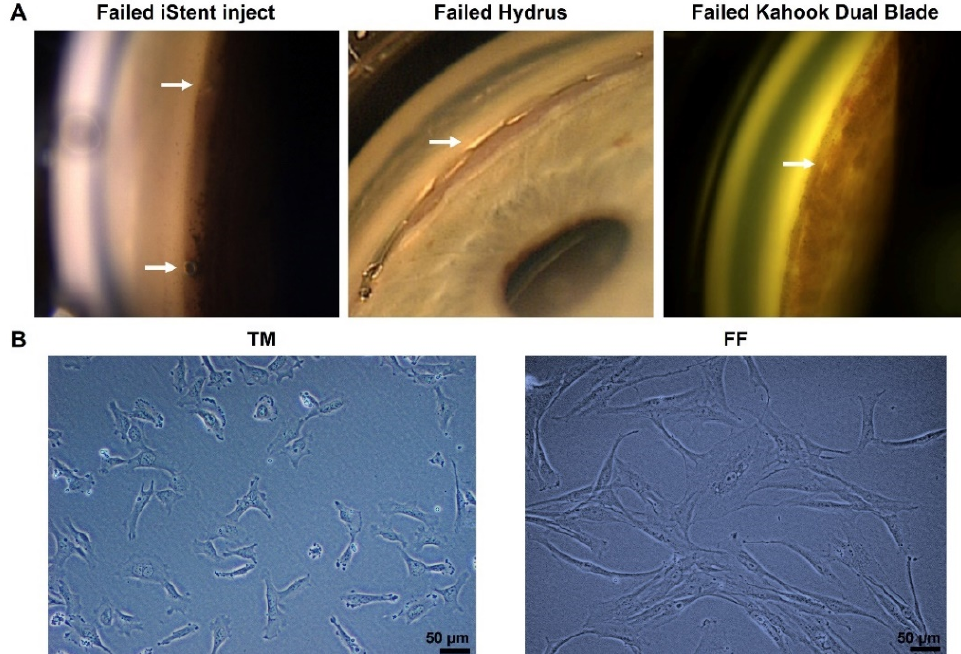
Figure 1. ( A ) Failed minimally invasive glaucoma surgery (MIGS) due to fibrosis. The arrow indicates scarring in iStent inject ( left ), Hydrus ( middle ), and the fibrotic membrane over the trabecular meshwork (TM) after Kahook Dual Blade surgery ( right ). ( B ) Phase-contrast microscopy images of human trabecular meshwork cells (TM, left ) and human conjunctival fibroblasts (FF, right ) cultured on plastic dishes. Scale bar, 50 μ m.